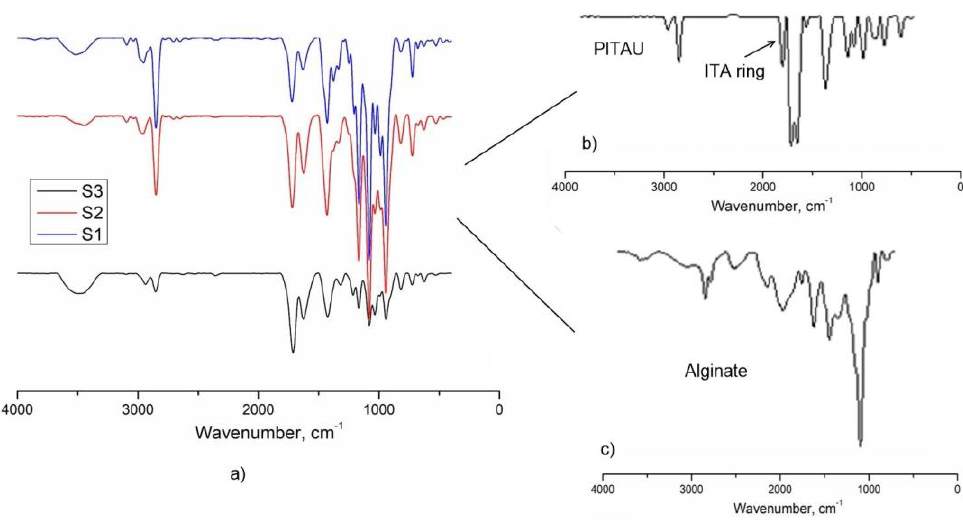
Figure 2. FTIR spectra of the ( a ) S1, S2, and S3 samples; ( b ) PITAU; ( c )